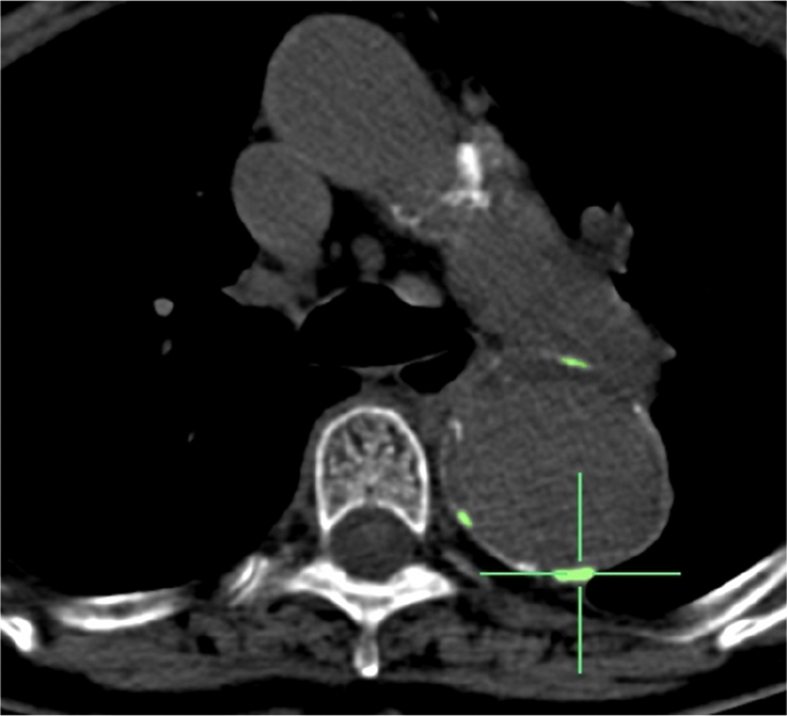
Calculation of calcium score using OsiriX. Example of thoracic aortic aneurysm scoring with scores derived from distal to left subclavian to upper aspect of coeliac axis using OsiriX.